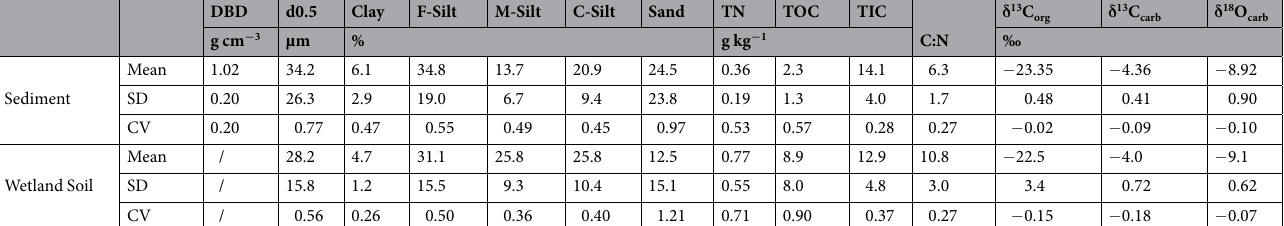
Table 1. Means, standard deviation (SD) and coefficients of variation (CV) of the main variables. Clay: < 2 µ m,